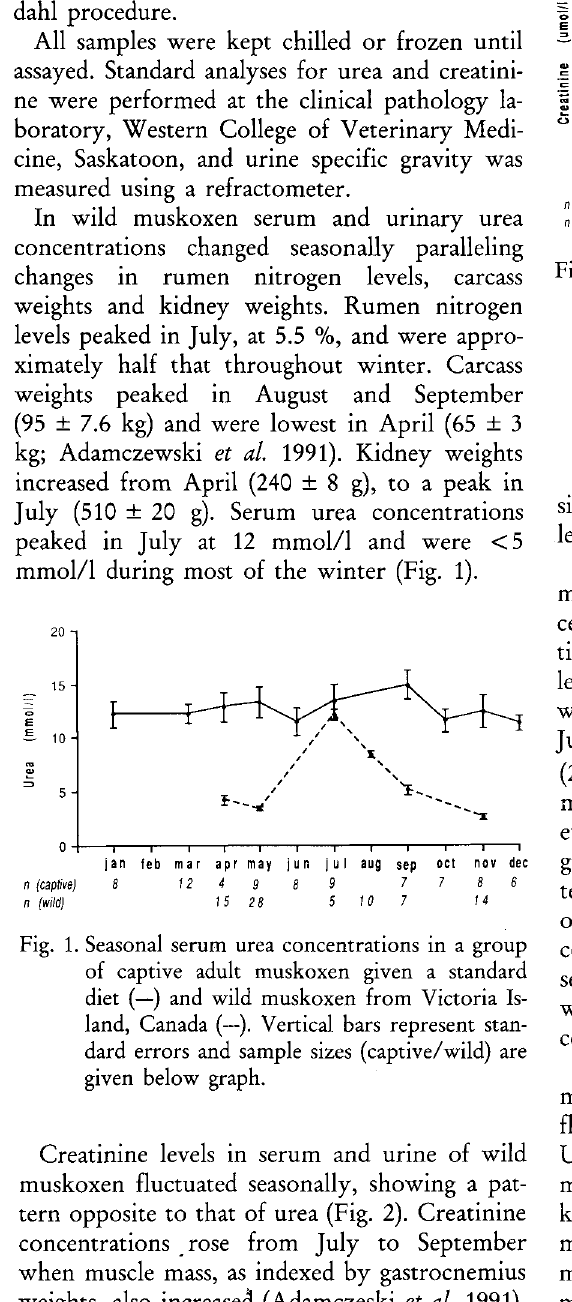
Fig. 2. Seasonal serum creatinine concentrations in a group of captive adult muskoxen given a stan dard diet (—) and wild muskoxen from Victo ria Island, Canada (--). Vertical bars represent standard errors and sample sizes (captive/ wild) are given below